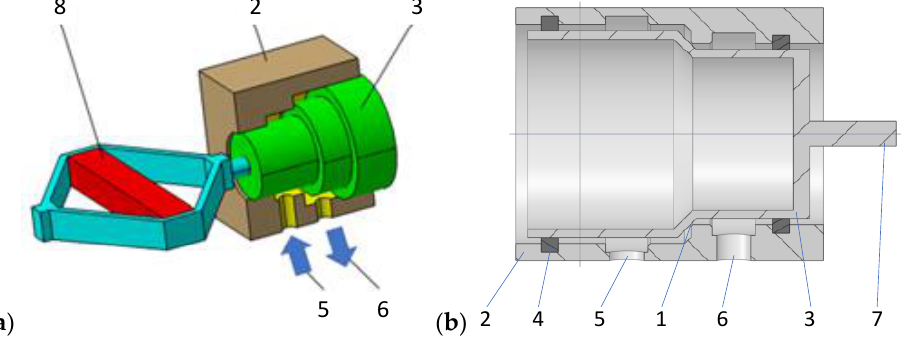
Figure 2. PZV valve: ( a ) valve diagram, ( b ) valve section view: 1 — the gap in PZV, 2 — housing, 3 — piston, 4 — sealing, 5 — above piston chamber channel, 6 — under piston chamber channel, 7 — pin, 8 — piezoelectric actuator.